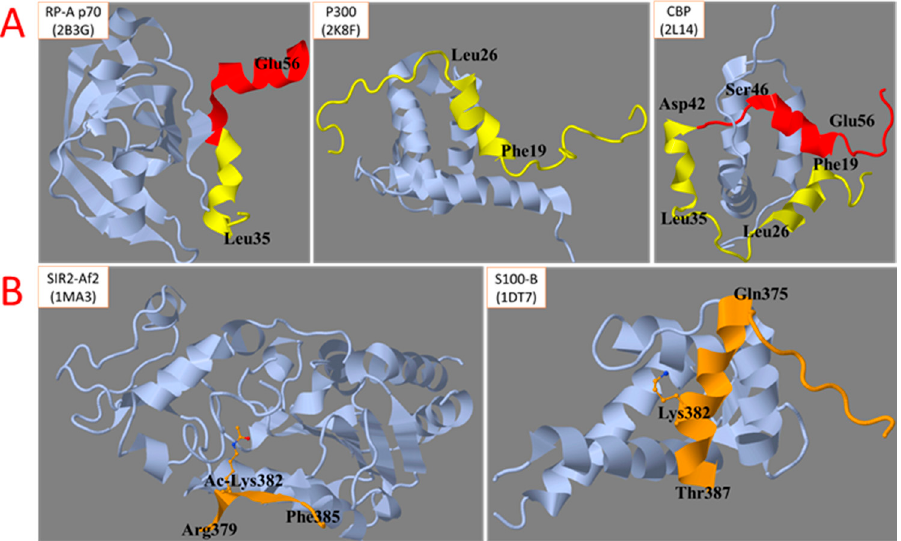
Figure 3. Structural changes of disordered regions of p53 upon the formation of heterologous protein complexes. ( A )—N-terminal region. ( B )—C-terminal region. The Uniprot names of the p53 partner proteins and pdb identifiers of the structures of their complexes with p53 regions involved in the interactions are indicated in the upper-left corner of each image.